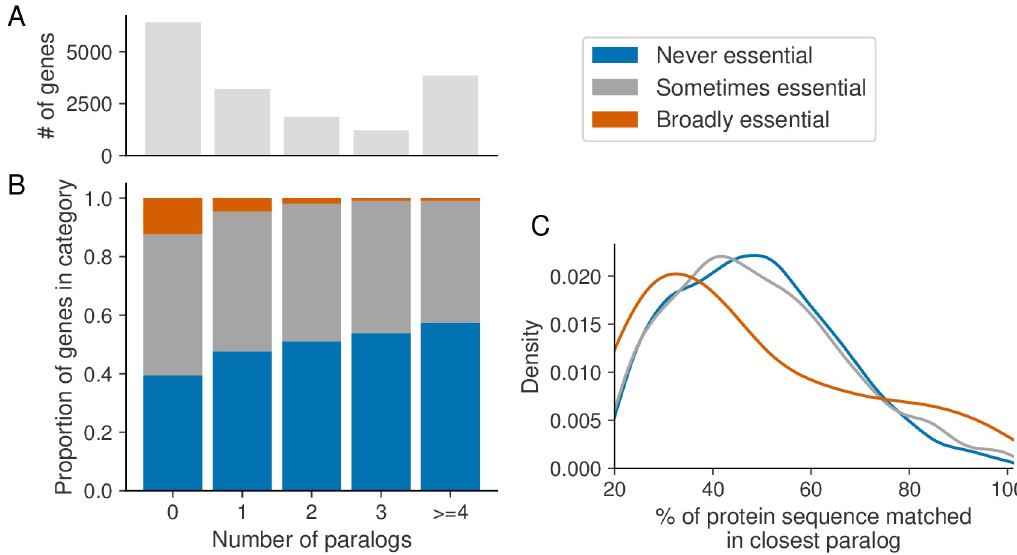
Fig 3. Genes with more paralogs and genes which share greater sequence identity with their closest paralog are less frequently essential. (A) Bar chart showing counts of the number of paralogs, from zero to four or more, for all protein-coding genes. (B) Stacked bar graph showing, for genes binned according to the number of paralogs they have, the proportion of genes in each bin that are never, sometimes and broadly essential. (C) The kernel density estimates of the percent of a gene’s protein sequence that is identical in its closest paralog, for paralogs in each essentiality category. Drawn using Seaborn’s kdeplot function with the default parameters.